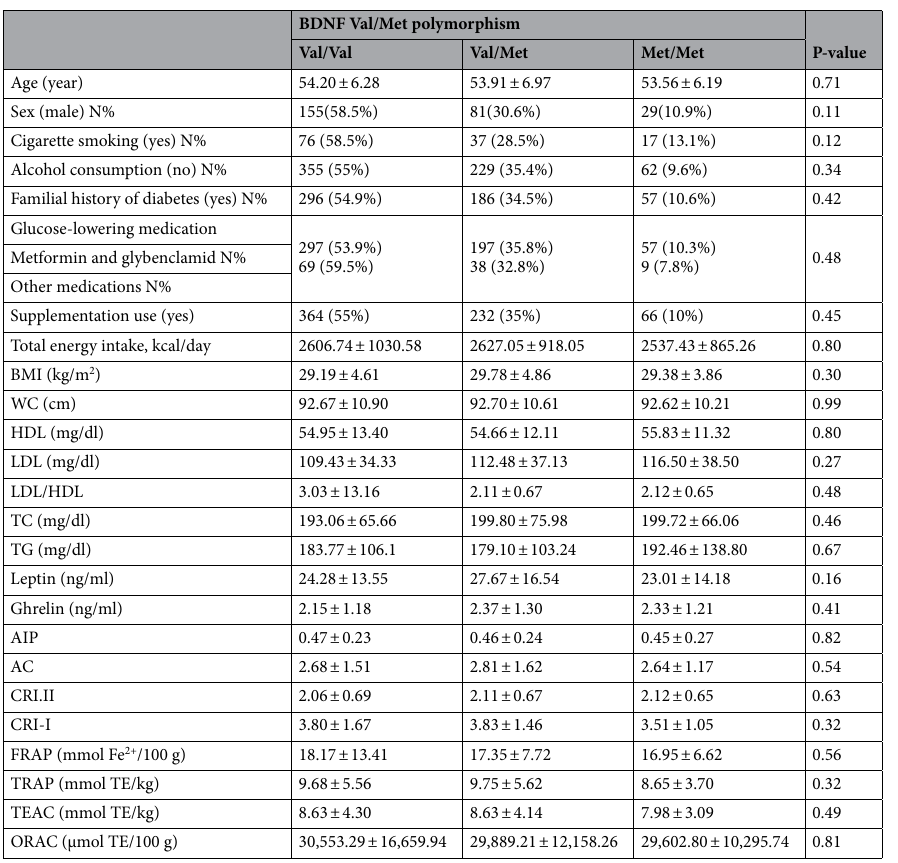
density lipoprotein cholesterol, LDL-c low density lipoprotein cholesterol, TG triglyceride, CRP C-reactive protein, PTX3 pentraxin-3, IL18 interleukin 18, TAC total antioxidant capacity, SOD superoxide